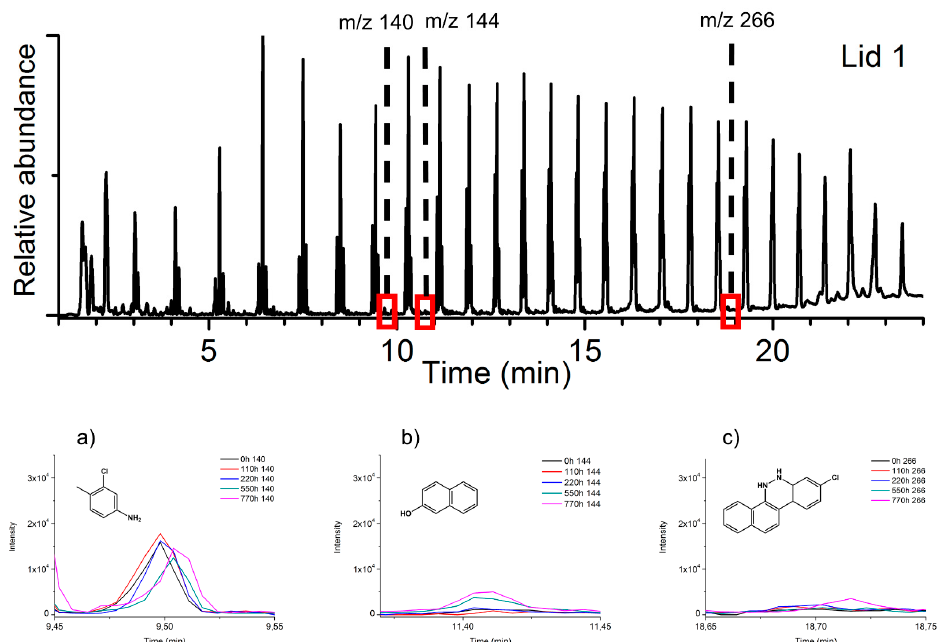
Figure 8. Normalized pyrogram of lid 1 at 0 h and related extracted ions (base peaks) of the main pyrolysis products of the pigment PR 48:2, M w 140 ( a ), M w 144 ( b ), and M w 266 ( c ), during the several aging steps (0–110–220–550–770 h).